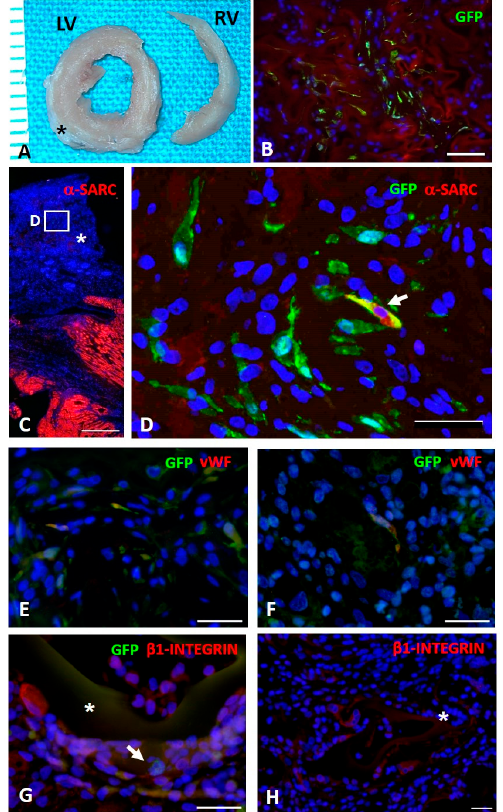
Figure 7. In vivo study. ( A ): Transverse sections of formalin fixed left (LV) and right (RV) ventricles of a cryoinjured rat heart (ten days) in which the sutured AGE sponge (black asterisk) is visible. ( B ): Immunohistochemical detection of green fluorescence protein (GFP pos ) CPCs (green) seeded on AGE + MIP-GRGDSP sponge sutured on a cryoinjured rat heart. C–F: Immunofluorescence detection of GFP pos CPCs di ff erentiation toward myocardial phenotypes. ( C ): Image taken at low magnification documenting by red fluorescence the spared myocardium labeled by alpha-sarcomeric actin ( α -SARC). The asterisk indicates the sutured AGE + MIP-YIGSR sponge in which the white rectangle inscribes the area shown at higher magnification in D. ( D ): GFP pos CPCs (green) located within AGE + MIP-YIGSR sponge sutured to the cryoinjured myocardium. Arrow points to a cell displaying cytoplasmic yellow fluorescence as a result of the co-expression of GFP (green) and α -SARC (red) and documenting the occurrence, after ten days from in vivo implant, of progenitor cells di ff erentiation toward myocardial phenotypes. Green fluorescence labeling depicts several undi ff erentiated GFP pos α -SARC neg cells. ( E , F ): Immunohistochemical analysis of GFP pos rCPCs (green) seeded on AGE + MIP-GRGDSP ( E ) and AGE + MIP-YIGSR ( F ) illustrating by yellowish fluorescence the co-expression of the endothelial marker von Willebrand factor (vWF, red). ( G ): Microscopic image illustrating by yellowish fluorescence the expression of β 1-Integrin (red) on GFP pos rCPCs (green, arrow) seeded on AGE + MIP-YIGSR (asterisk) implanted on the cryoinjured myocardium. ( H ): Microphotograph documenting the expression of β 1-Integrin in resident myocardial cells located at the edge of unseeded AGE (CTRL) sponge (asterisk). To highlight the presence of β 1-Integrin pos fluorescent CPCs, contrast enhancement of the red (TRITC) channel was applied to show the reddish autofluorescence background of the sponge. In B–H, blue fluorescence corresponds to DAPI staining of nuclei. Scale bars: B = 50 µ m, C = 500 µ m, D, E, F and H = 30 µ m; G = 20 µ